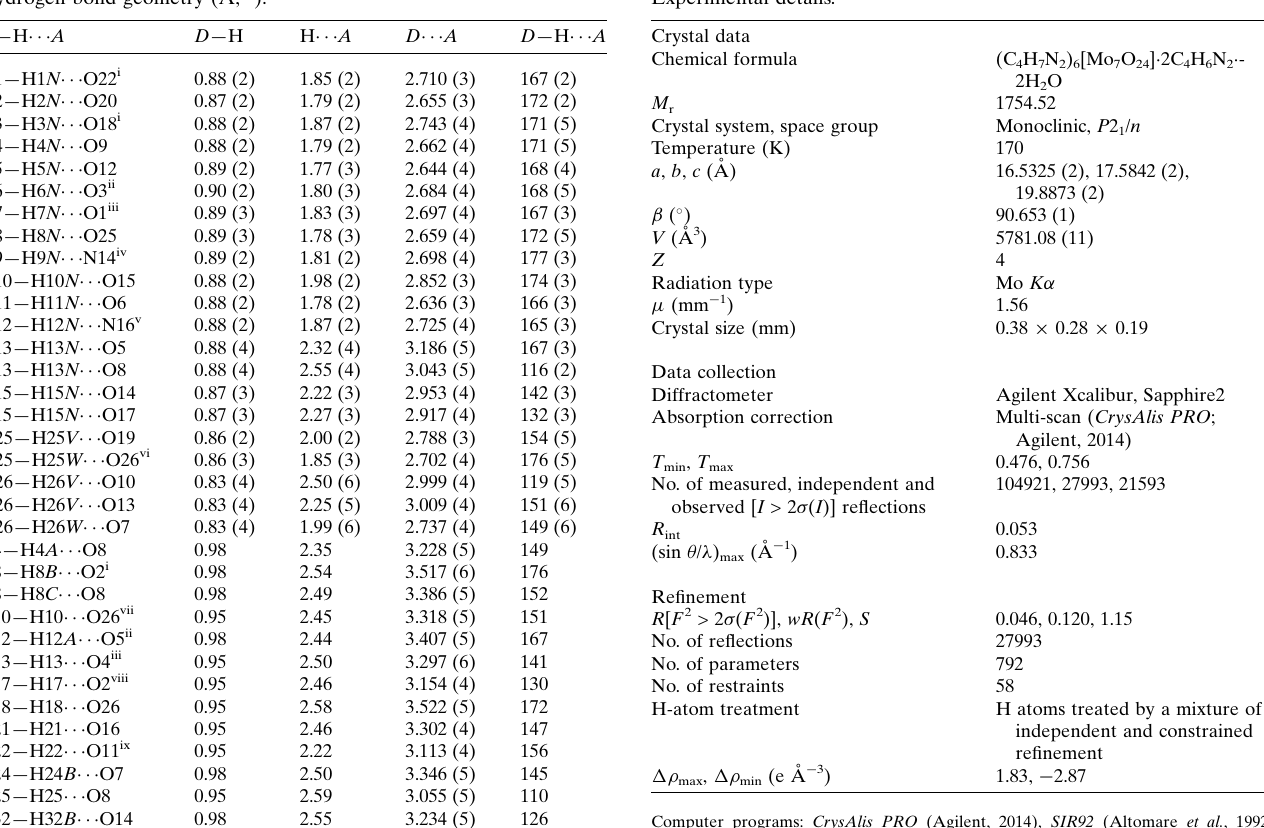
Table 1 Hydrogen-bond geometry (A˚ , (cid:5)